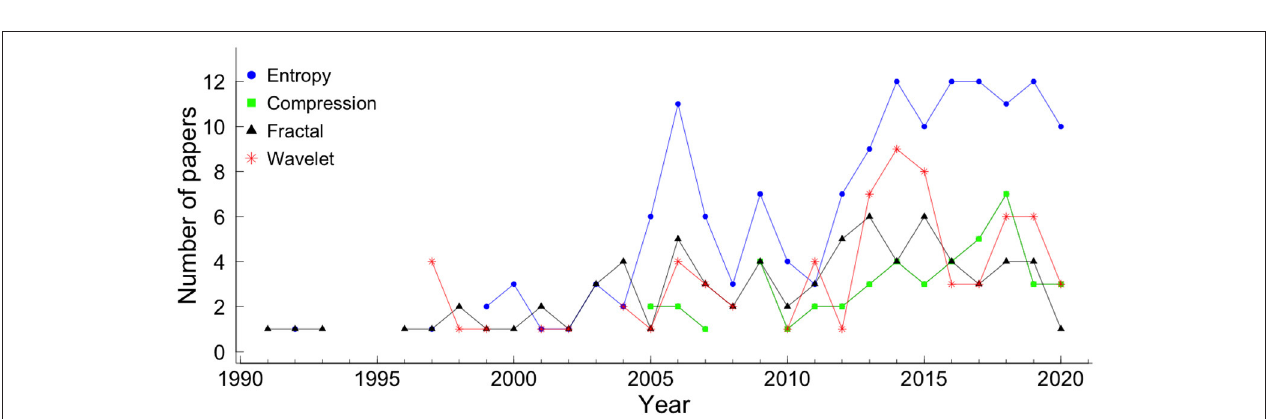
FIGURE 2 | The number of papers, covered by the systematic review, that applied each method. The blue circle represents entropy, the green square represents compression, the black triangle represents fractal analysis, and the red star represents wavelet.